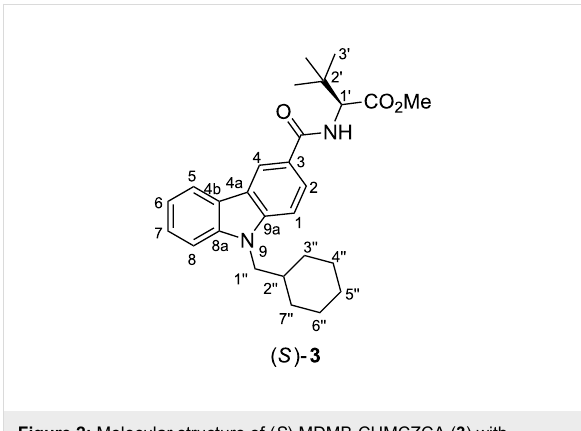
Figure 2: Molecular structure of ( S )-MDMB-CHMCZCA ( 3 ) with numbering scheme.